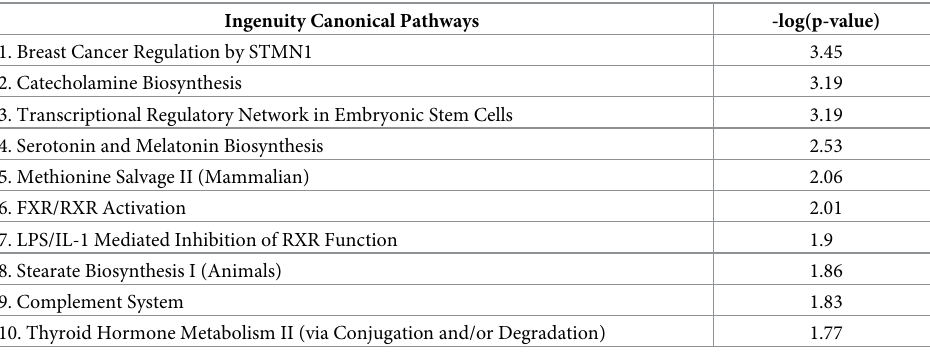
Table 7. Pathway analysis of genes differentially expressed between DACH1 mutated patients and